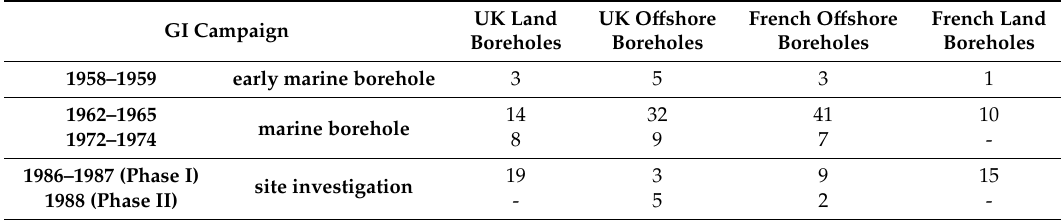
Table 2. Boreholes drilled in every Ground Investigation (GI) Campaign